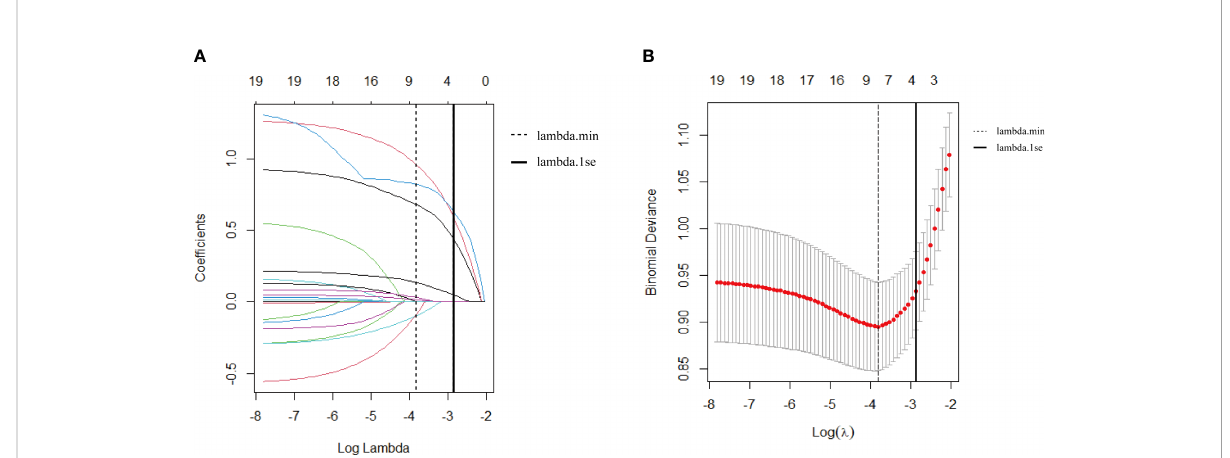
FIGURE 2 (A) Feature selection via the least absolute shrinkage and selection operator (LASSO) regression model. (A) The LASSO coef fi cient pro fi les of 19 features. The coef fi cient pro fi le plot was conducted against the log (lambda, l ) sequence. The dotted vertical line was drawn at the lambda with a minimum mean squared error (lambda.min); nine features were selected by the LASSO regression. The solid vertical line was drawn at the lambda.min with one standard error (lambda.1se); four features were selected by the LASSO regression model. (B) Feature selection via 10-fold cross-validation. (B) The optimal parameter (lambda, l ) selection in the Lasso regression model used 10-fold cross-validation via the minimum criteria. The partial likelihood deviance (binomial deviance) curve was plotted versus log l . The dotted vertical line was drawn at the lambda with a minimum mean squared error (lambda.min); nine features were selected. The solid vertical line was drawn at the lambda.min with one standard error (lambda.1se); four features were